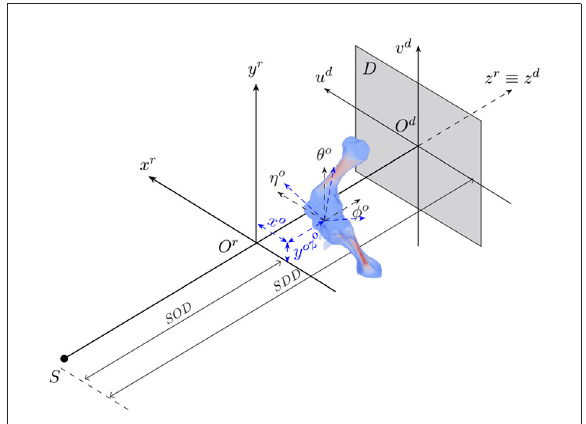
FIGURE1 The geometry of a cone-beam acquisition system with an X-ray source S and a detector plane D . Object position and orientation